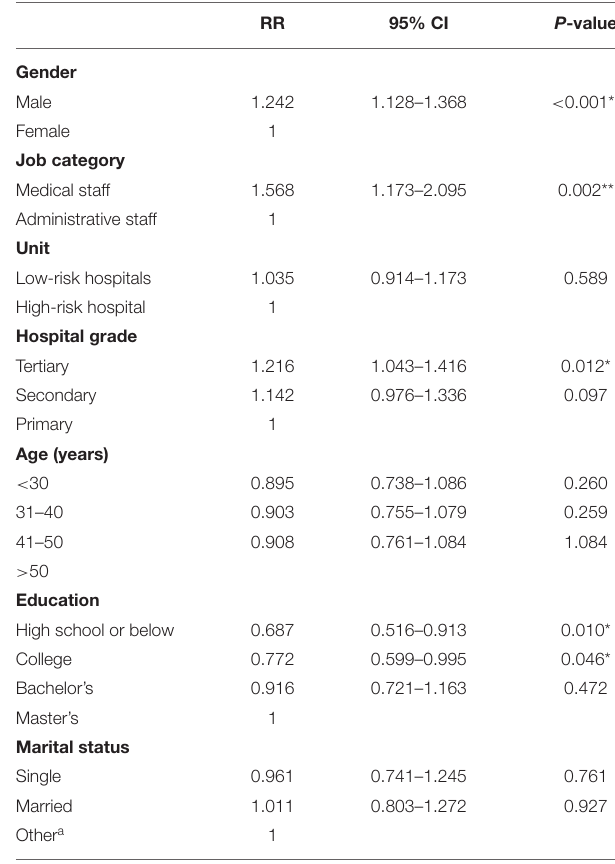
TABLE 3 | Association between participant characteristics and COVID-19 prevention